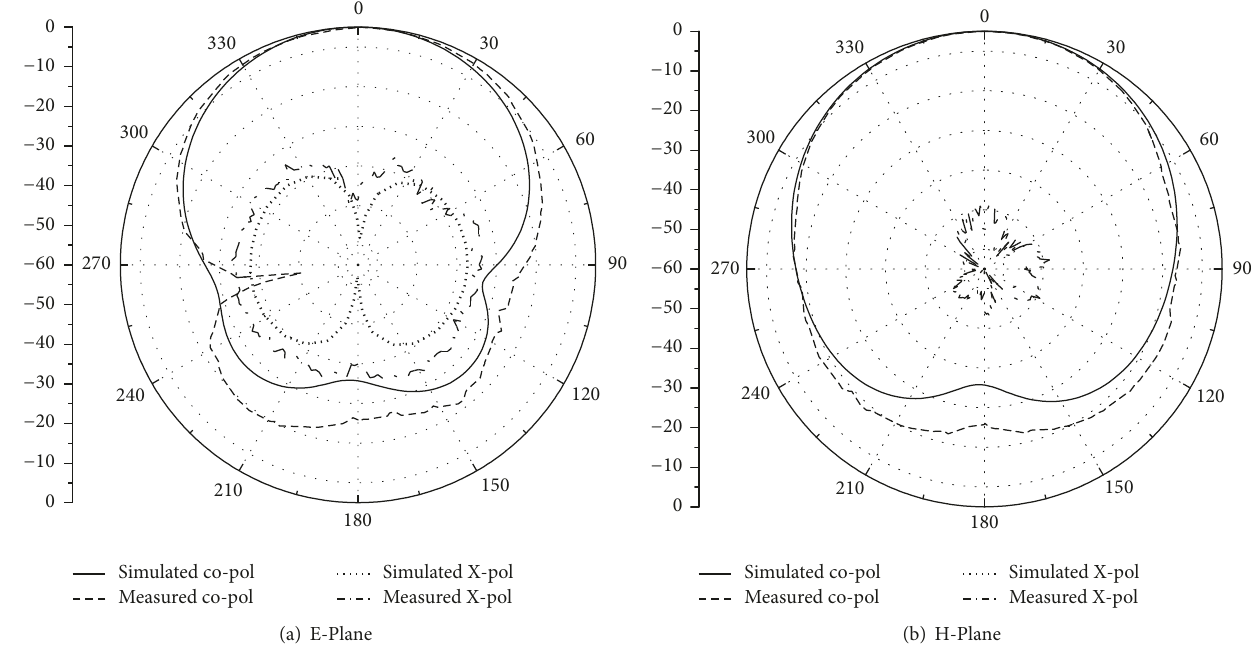
Figure 8: Simulated and measured radiation patterns of the proposed antenna at 2 GHz.